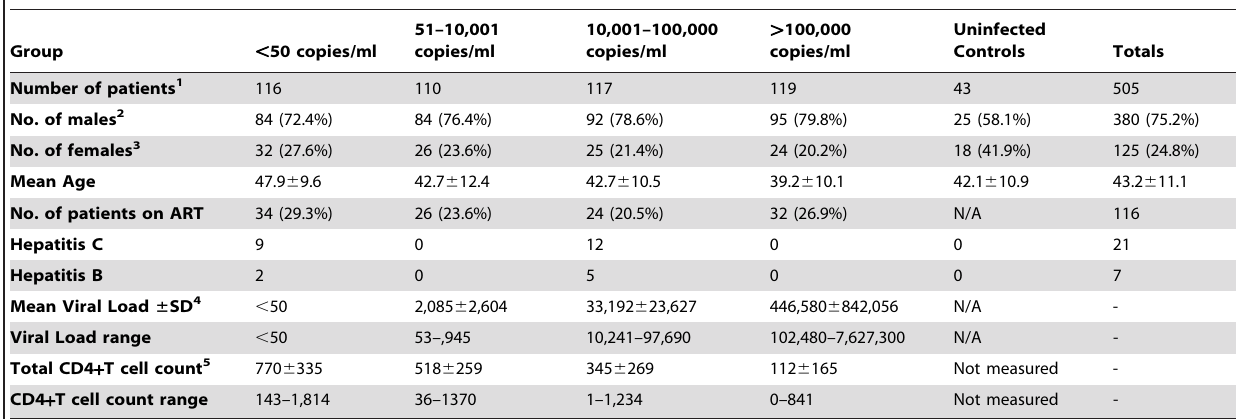
Table 1. Demographics of patients used in